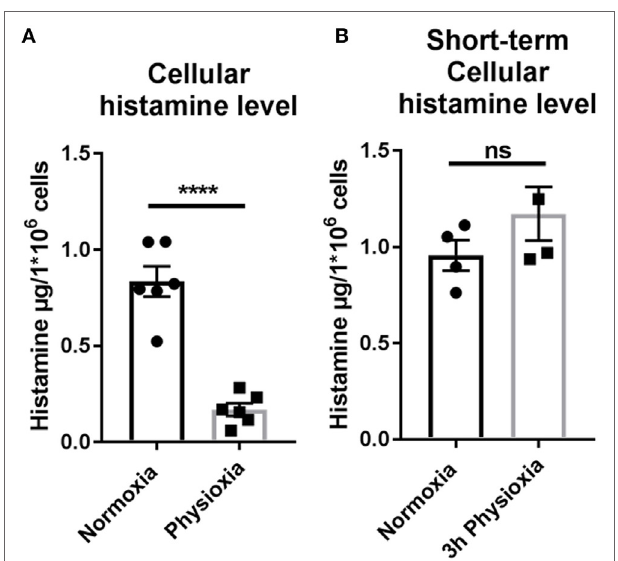
FiGUre 5 | (a) Intracellular histamine storage after physioxic differentiation measured by high performance liquid chromatography. The amount of intracellular stored histamine is significantly reduced in MCs differentiated under low oxygen levels. Depicted are mean values and SEM from cells of n = 6 individual BMMC batches. (B) Intracellular histamine storage of normoxic differentiated cell after short-term (3 h) physioxia in comparison to normoxia. No difference in intracellular storage of histamine is observed. Depicted are single values and SEM from cells of minimum n = 3 (six mice, two mice pooled for each batch) individual